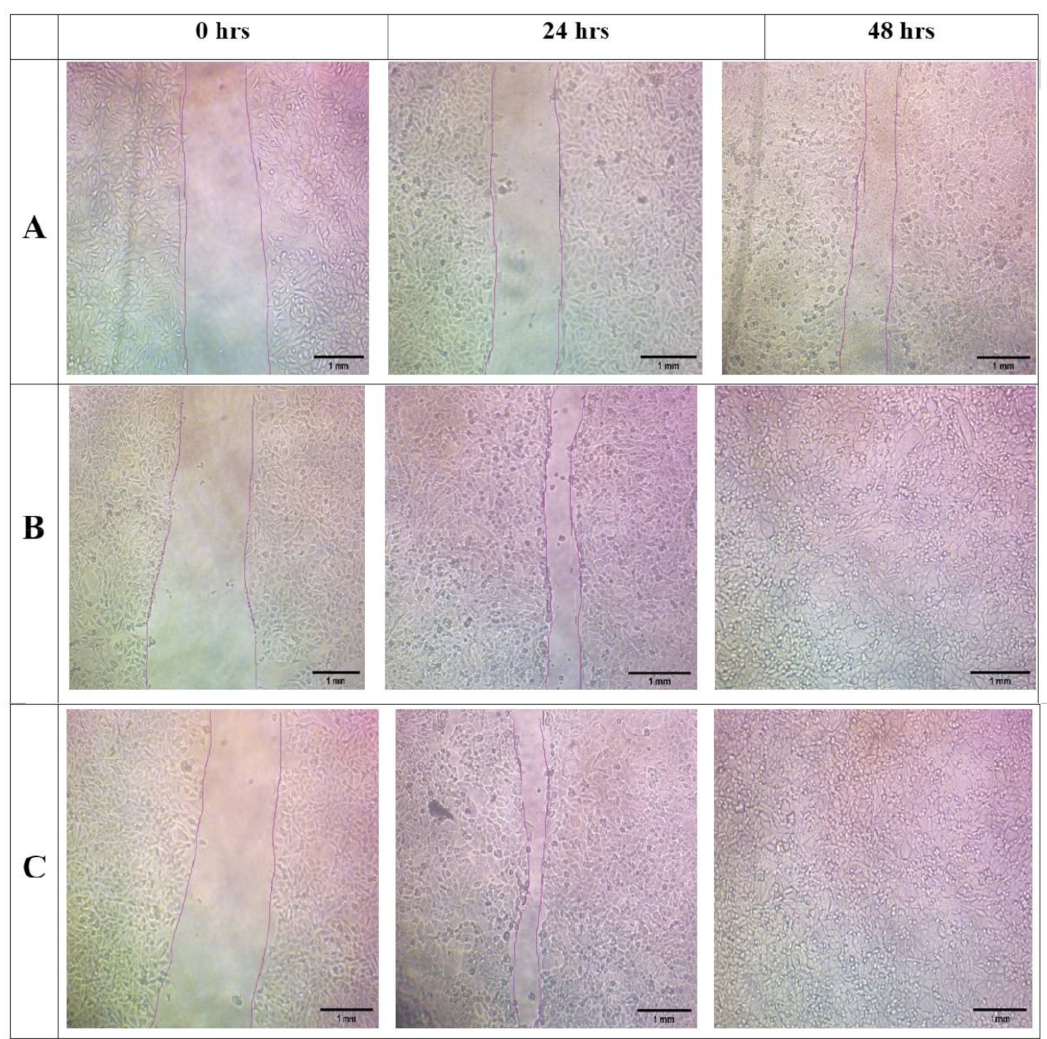
Figure 11. Images of in vitro scratch assay of formulations of ( A ) (control), ( B ) (FA-SS-PCL-NF), and ( C ) (FA-SS-CA-NF) at 0, 24, and 48 h (scale bar = 1